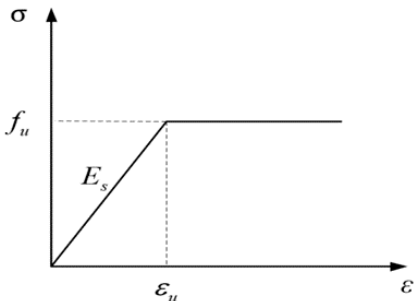
Figure 4. Ideal elastic-plastic stress-strain curve for reinforcement.